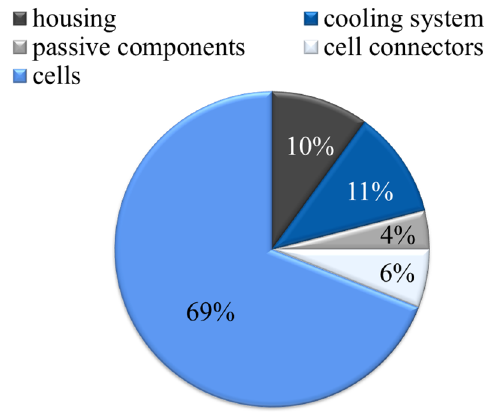
Figure 11. Weight distribution of the battery system in Smart Wheels.